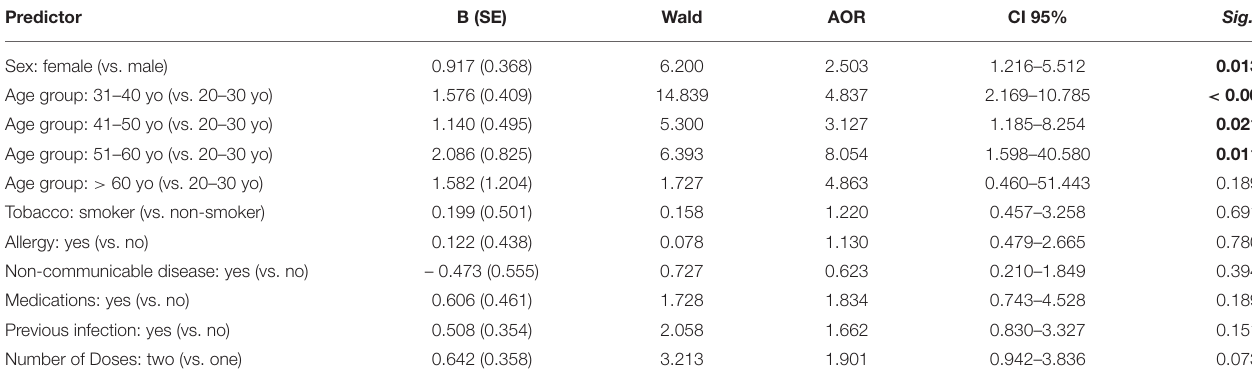
TABLE 8 | Logistic regression of risk factors for adenoviral vector vaccine side effects reported by Algerian healthcare workers ( n = 271). Predictor B (SE) Wald AOR CI 95% Sig. Sex: female (vs. male) 0.917 (0.368) 6.200